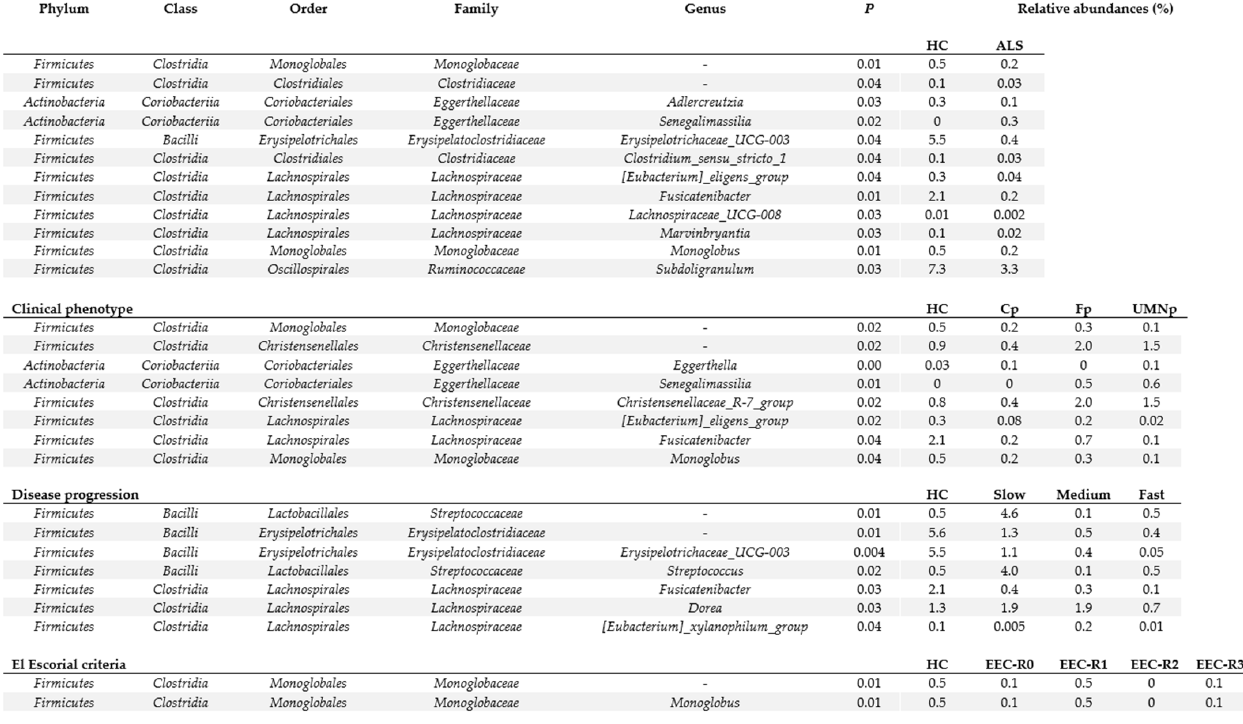
Figure 5. Significant differentially abundant taxa among ALS patients and controls. ALS = amyotrophic lateral sclerosis. HC = healthy controls. EEC = EL Escorial Criteria; EEC-R0 = definite; EEC-R1 = clinically probable; EEC-R2 = probable- laboratory-supported; EEC-R3 = possible. Bp = Bulbar phenotype; Cp = Classic phenotype; Fp = Flail arm/leg phenotype; UMNp = Upper Motor Neuron predominant phenotypes.